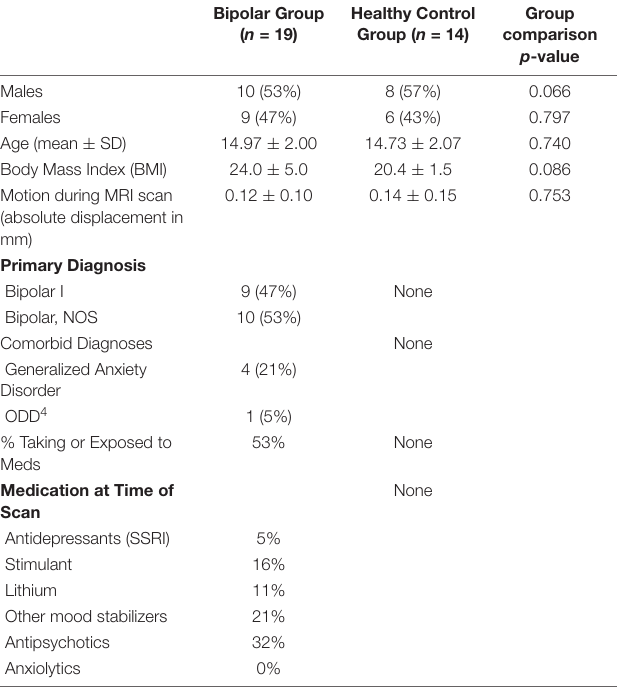
TABLE 1 | Description of